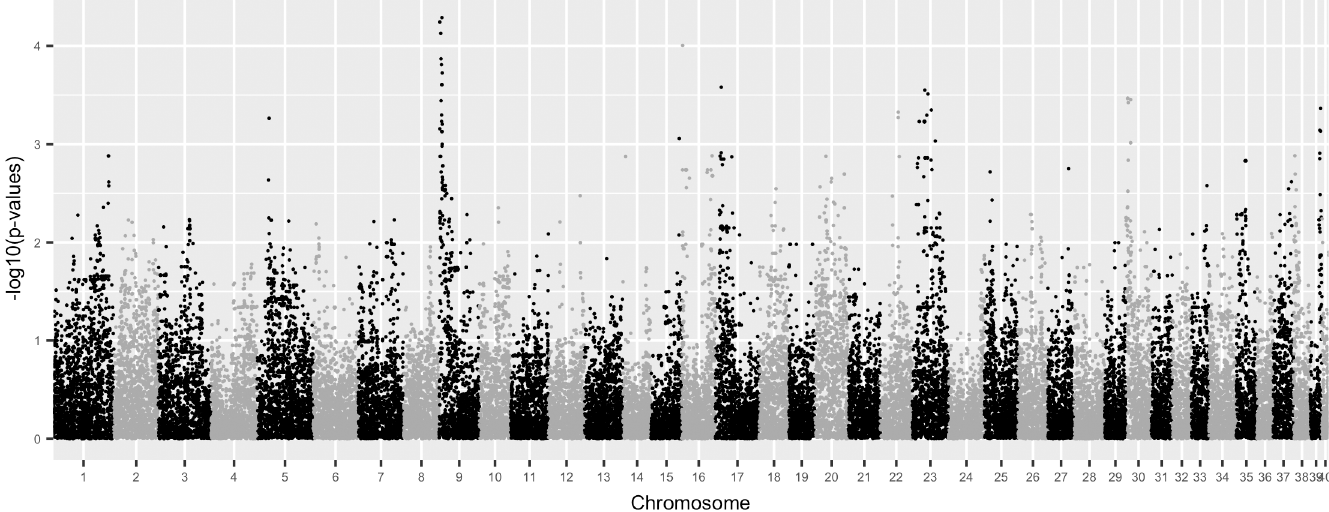
Fig 1. GWAS Manhattan plot for logistic mixed model analysis showing association of XX DSD to CFA9 in the canine model pedigree. The probabilityof association [-Log 10 ( P )] is shown for singlenucleotidepolymorphisms (SNPs) on chromosomes1–40. (Quantile-Quantileplot of the p-values is in S3